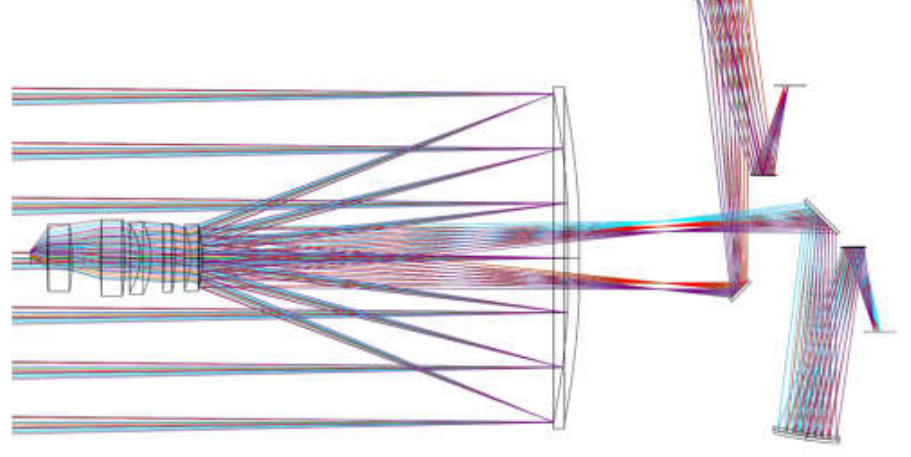
Figure 11. The overall optical design.